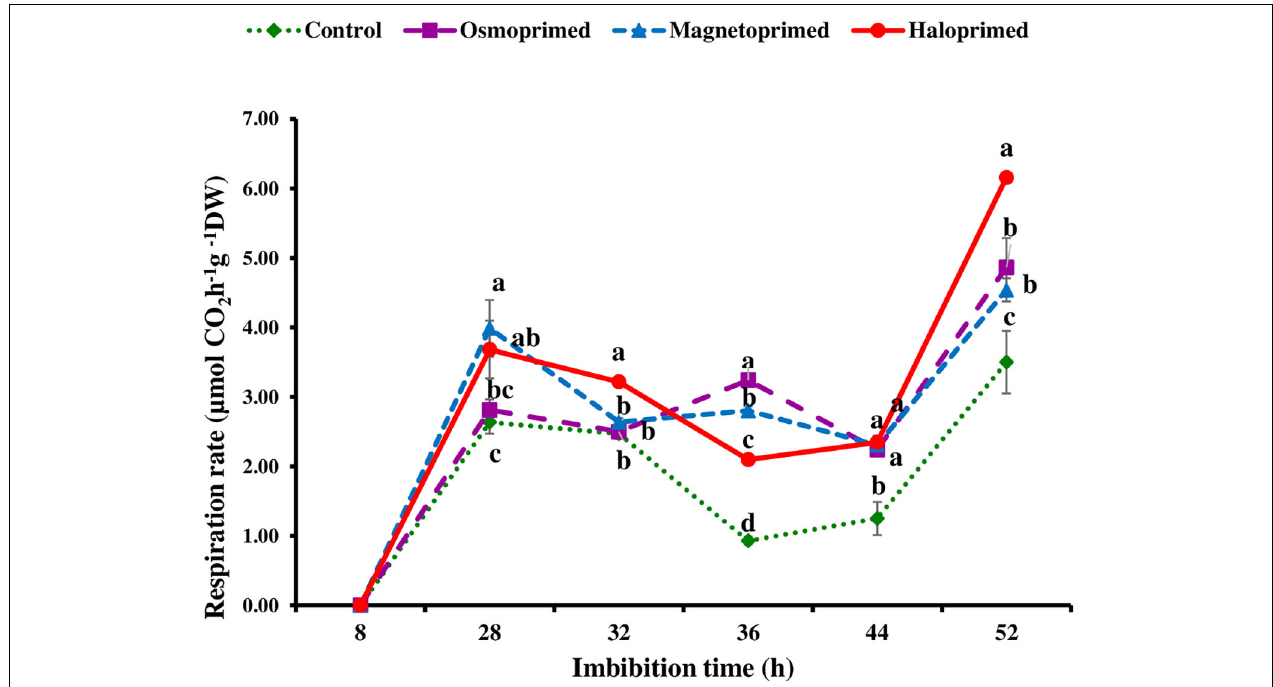
FIGURE 4 | Respiration rate of differently primed onion seeds at different imbibition time. Data represent mean ± SE of three biological replications. Different letters indicate significant differences among means based on LSD test ( p < 0.05).